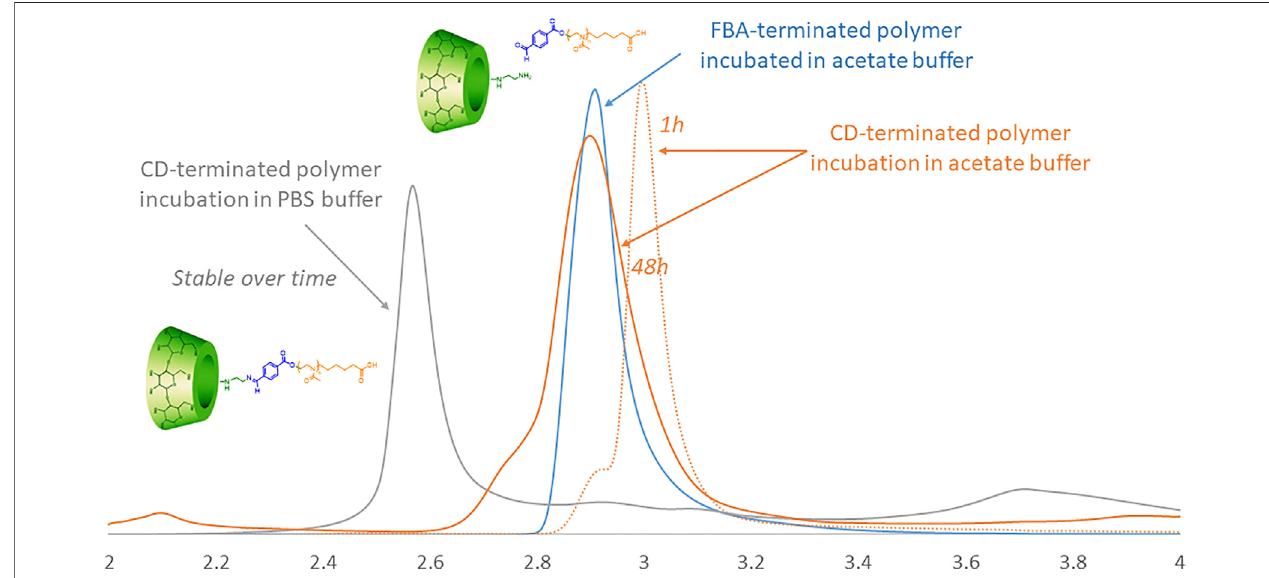
FIGURE 3 | HPLC traces of CD-terminated polymer incubated in acetate over time (orange) in comparison to the same polymer in PBS (grey) and the reference FBA-terminated polymer incubated in acetate buffer (blue).